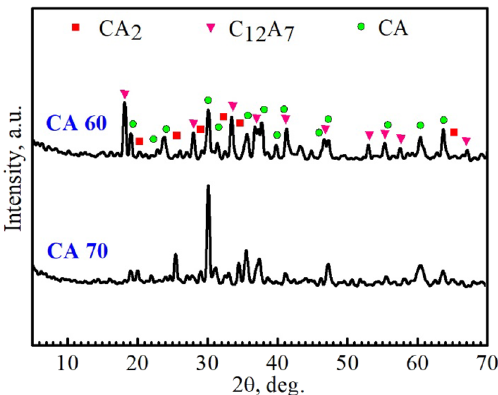
Figure 3. Powder XRD patterns of the compacted specimens sintered at 1450 °C.